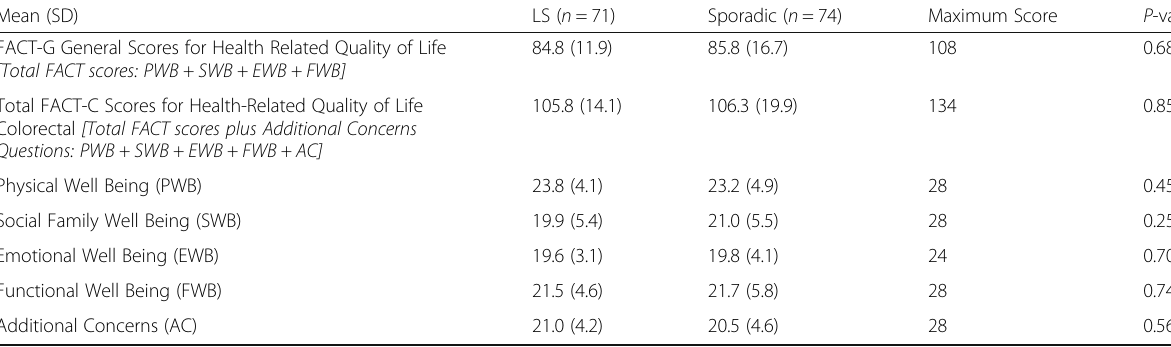
Table 2 FACT-C Health-Related Quality of Life Mean